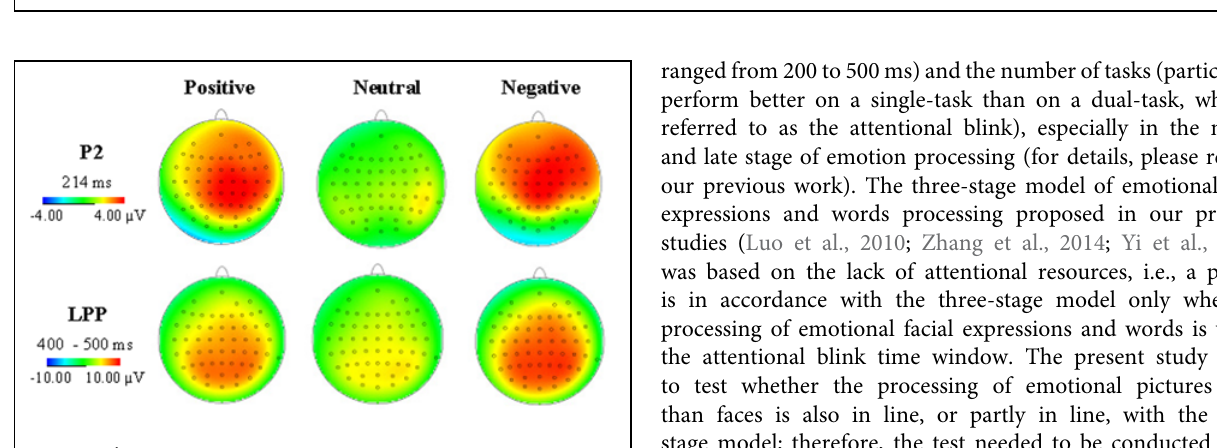
FIGURE 4 | Average ERP topographies of the P2 and LPP components across three emotional